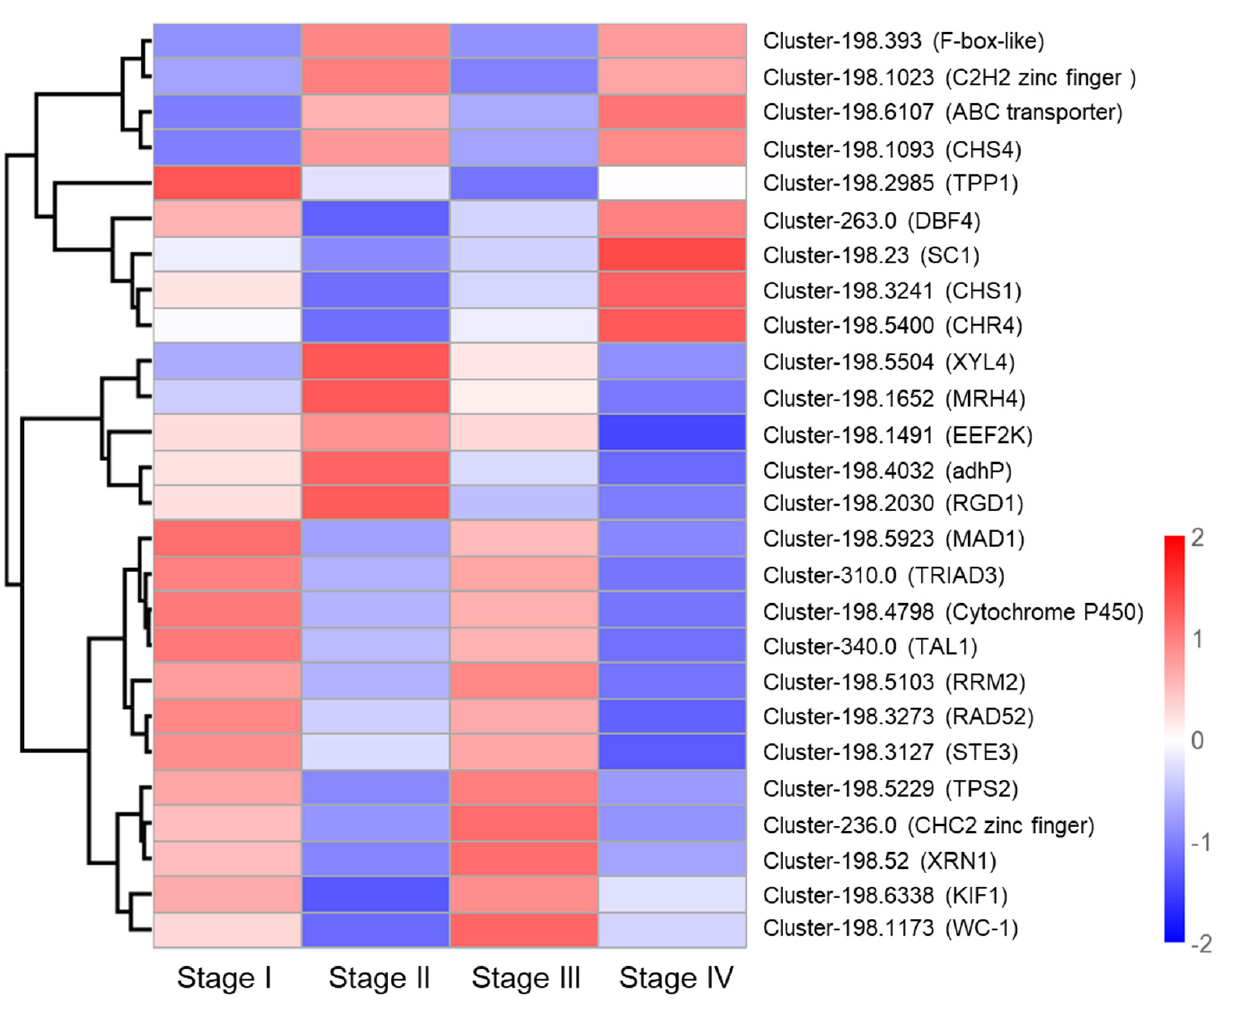
Figure 8. Heat map analysis of 26 DEGs associated with primordium formation.